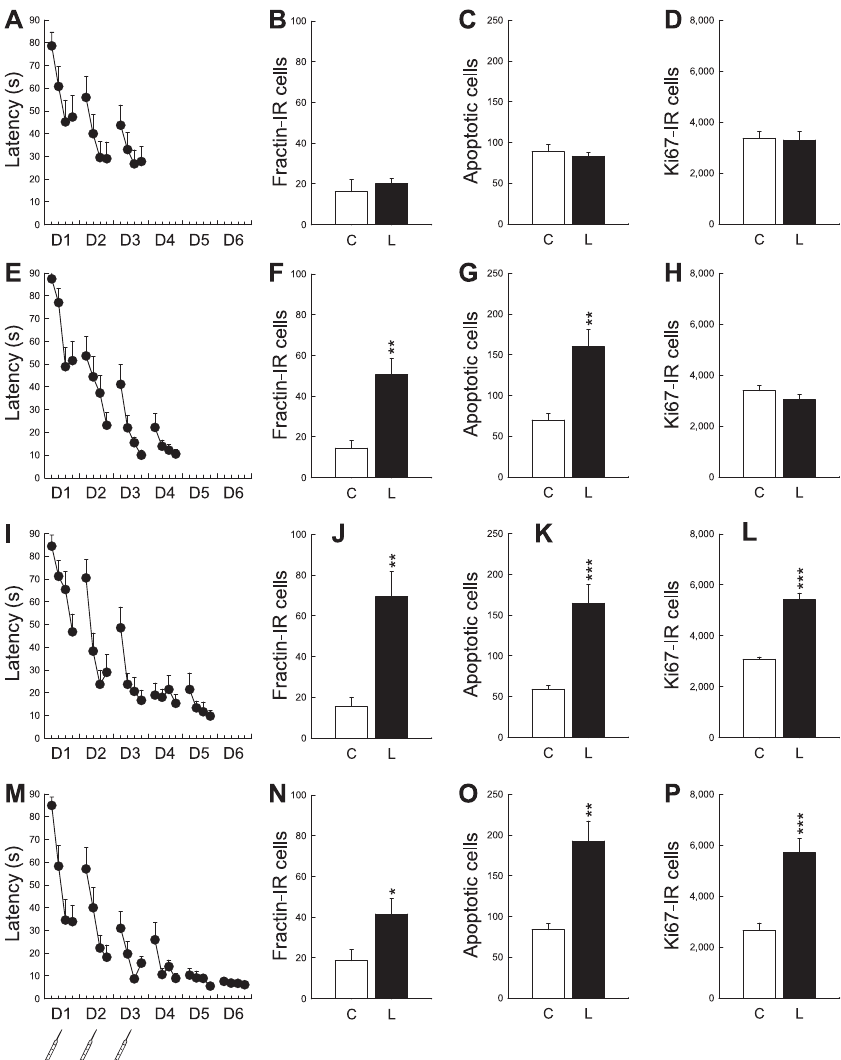
Figure 4. The Stabilization of Spatial Performances Increases Cell Death and Cell Proliferation in the Dentate Gyrus (A, E, I, and M) Latency to find the escape platform. The syringes represent BrdU injections. D, day. (B, F, J, and N) Apoptosis measured by the number of fractin-IR cells. (C, G, K, and O) Apoptosis measured by the number of both pyknotic and karyorrhexic dying cells. (D, H, L, and P) Cell proliferation measured by the number of Ki67-IR cells. A single asterisk (*) indicates p (cid:2) 0.05, double asterisks (**) indicate p (cid:2) 0.01, and triple asterisks (***) indicate p (cid:2) 0.001 compared to Control groups. Error bars represent the